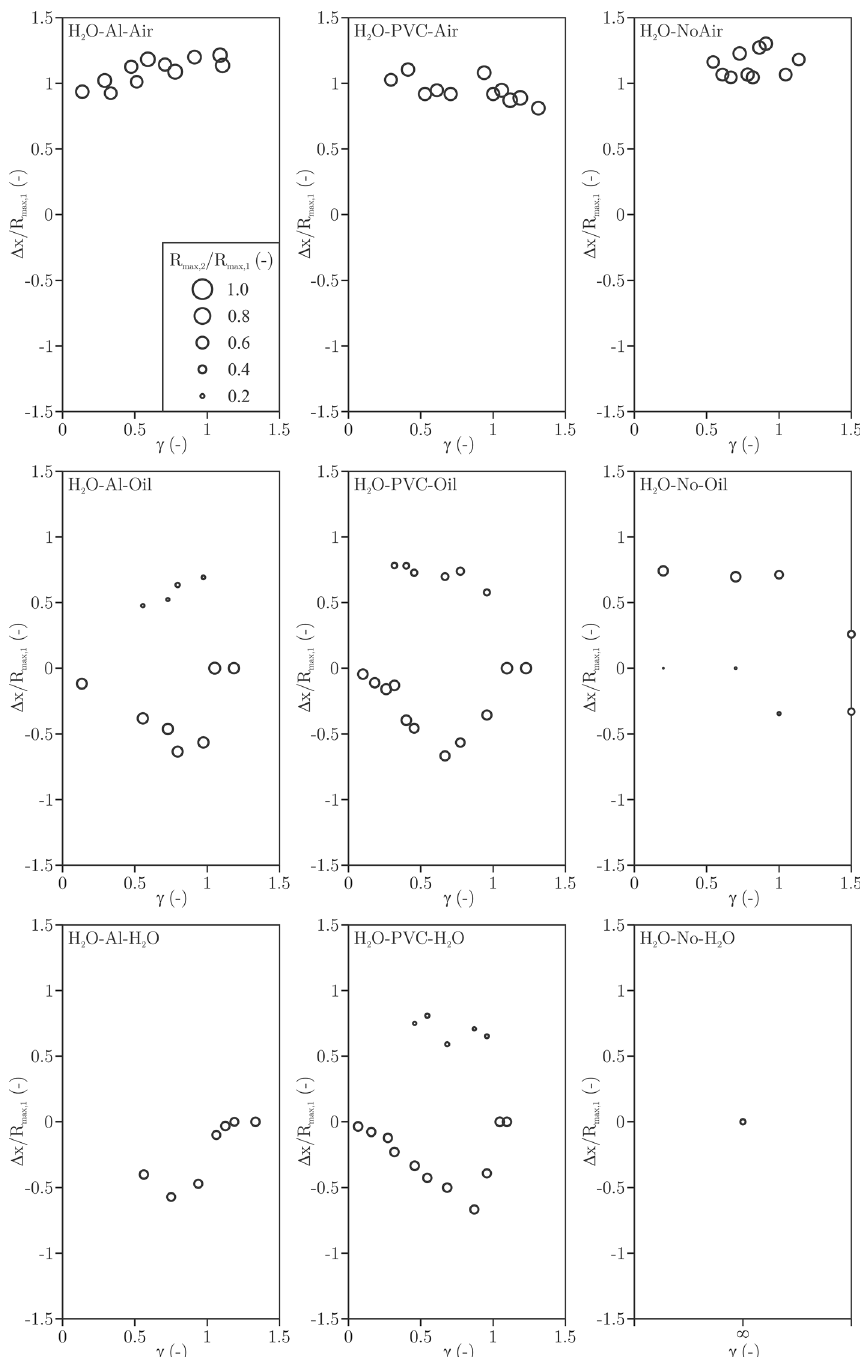
Figure 6. Displacement of the rebounded bubble(s) together with their radius (given by the size of the circle) nondimensionalized against the maximum radius of the bubble as function of γ and the type of fluid-interface- fluid